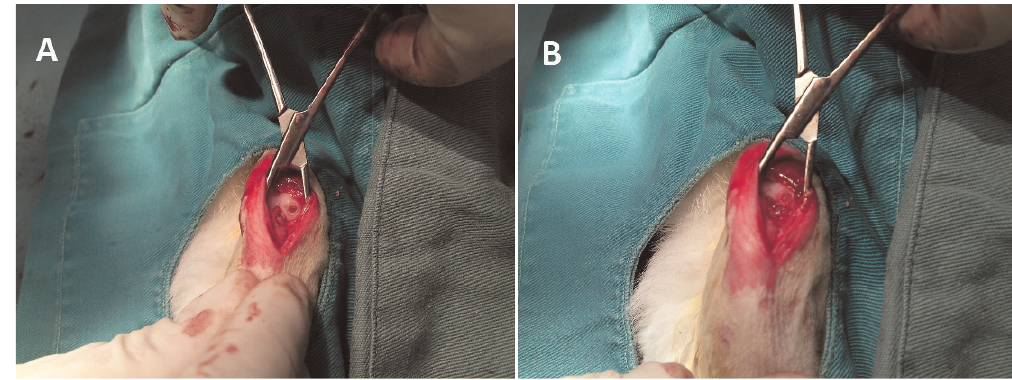
Figure 1 - Chondral injury before (A) and after (B) platelet gel application (source: personal